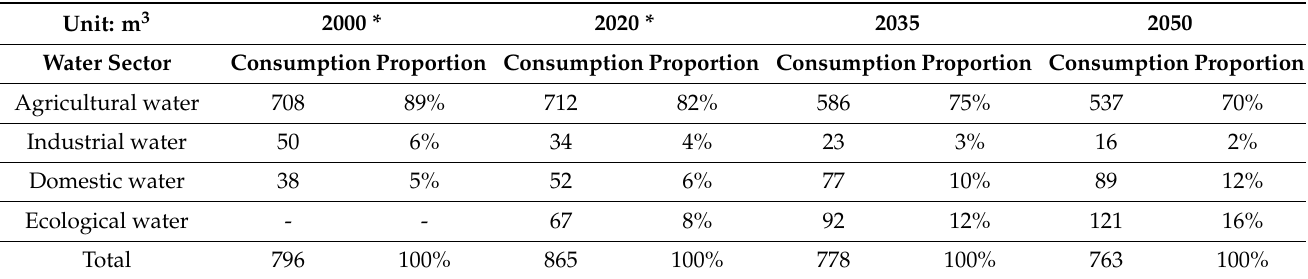
Table 5. Utilization structure of water resources in Northwest China.